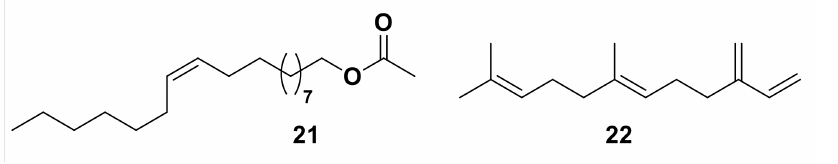
Figure 4. The chemical structure of ( Z )-vaccenyl acetate (VA) 21 , the male sex pheromone of D. melanogaster , and ( E )- β -farnesene 22 , the aphid alarm pheromone. Expression of the gene encoding for a specific OBP can be suppressed, resulting in lower levels of gene expression, or the DNA encoding for the gene can be knocked out,